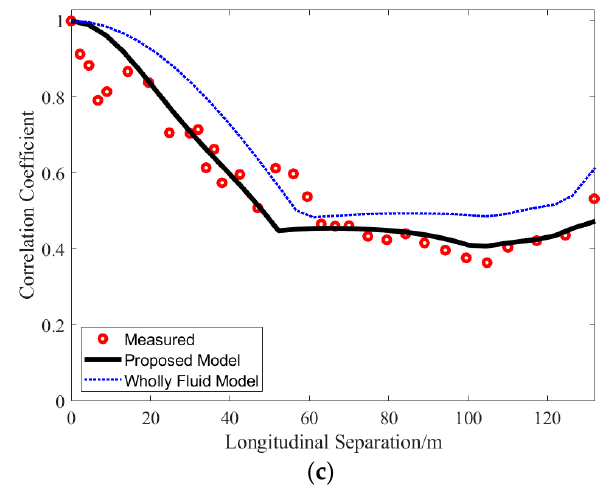
Figure 9. Measured sound spatial correlations corresponding to 1/3 octaves of ( a ) 150, ( b ) 200, and ( c ) 250 compared to simulation results. Solid dark and dashed blue lines were obtained by using geoacoustic parameters inverted based on proposed and wholly fluid bottom models, respectively.